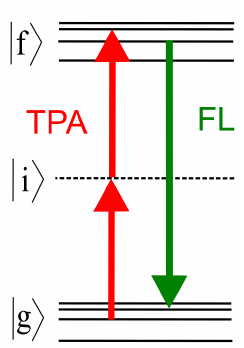
Figure 1. Sketch of two-photon excited fluorescence (TPEF). Two-photon absorption (TPA) occurs from a ground state | ψ g (cid:105) to a final state | ψ f (cid:105) via an intermediate state | ψ i (cid:105) with an intermediate state lifetime τ i , followed by the subsequent emission of a fluorescence photon